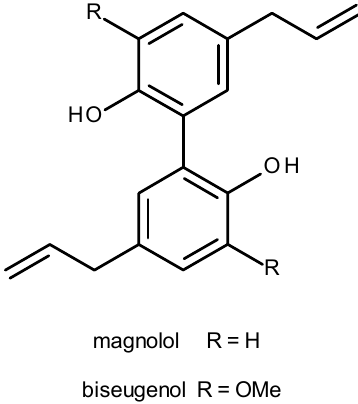
Figure 1. Chemical structures of magnolol and biseugenol.